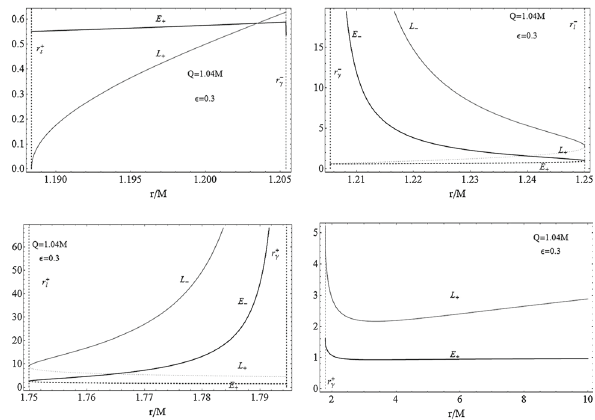
√ √ Fig. 13 Class : 5 /( 2 6 ) M < Q < ( 3 6 / 7 ) M and 0 < (cid:2) < (cid:9)(cid:9) (cid:2) − . Parameter choice is as follows: Q = 1 . 04 M and (cid:2) = 0 . 3. Then (cid:9)(cid:9) (cid:2) − = = 0 . 338294, r + s = 1 . 18836 M , r − γ = 1 . 20538 M , r + γ = 1 . 79462 M , r − l = 1 . 74993 M . Circular orbits exist with angular 1 . 25007 M , and r + l momentum L = L − ( gray curves ) and energy E = E − ( black curves )